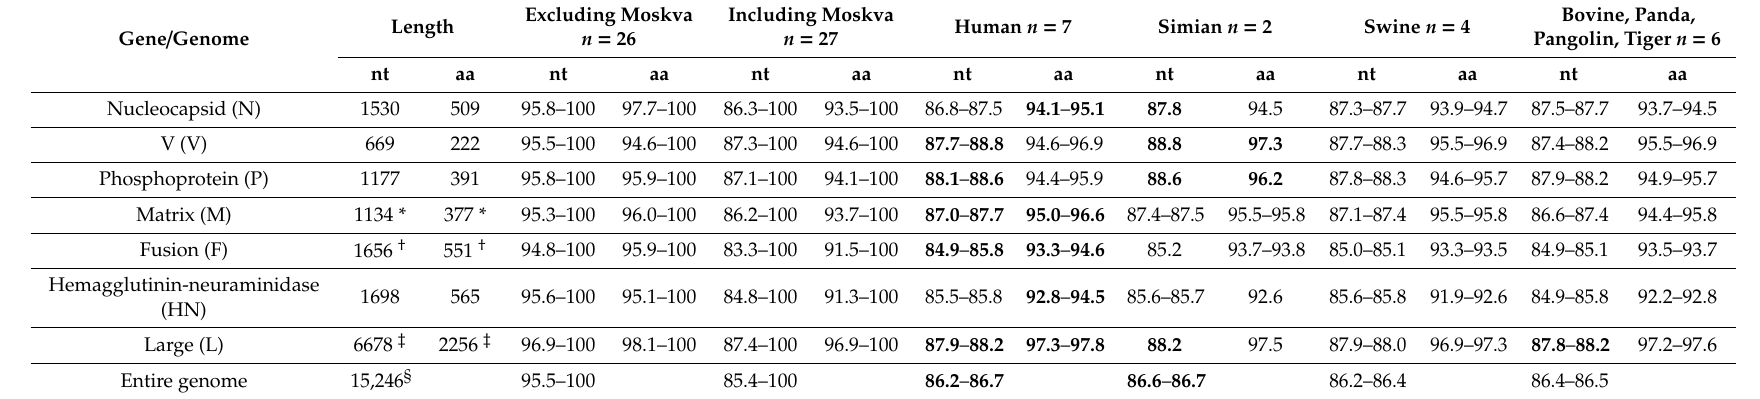
Table 1. Comparison of the nucleotide (nt) and amino acid (aa) lengths and identity for PIV5